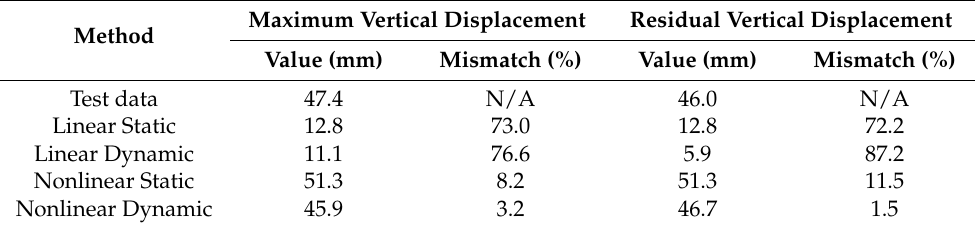
Figure 7. Comparison of vertical displacements obtained from numerical simulations and experiment. Table 1. Comparison of maximum and residual vertical displacements with test data.